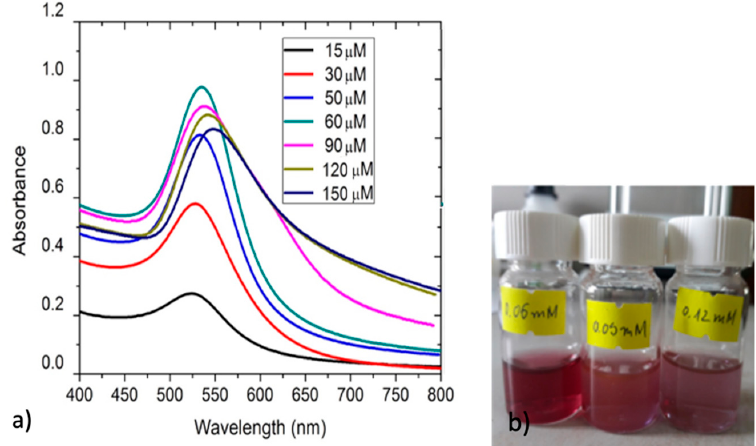
Figure 4. Absorption spectra (a) and images (b) of the different gold nanoparticle solutions synthesized from different precursor concentrations.